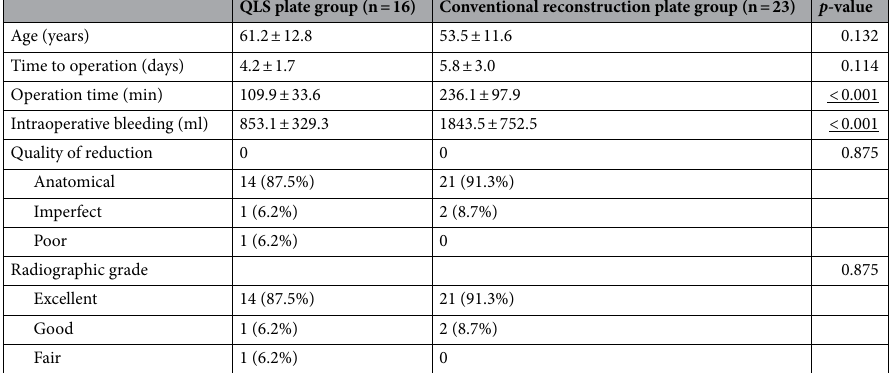
QLS plate group (n = 16) Conventional reconstruction plate group (n = 23) p -value